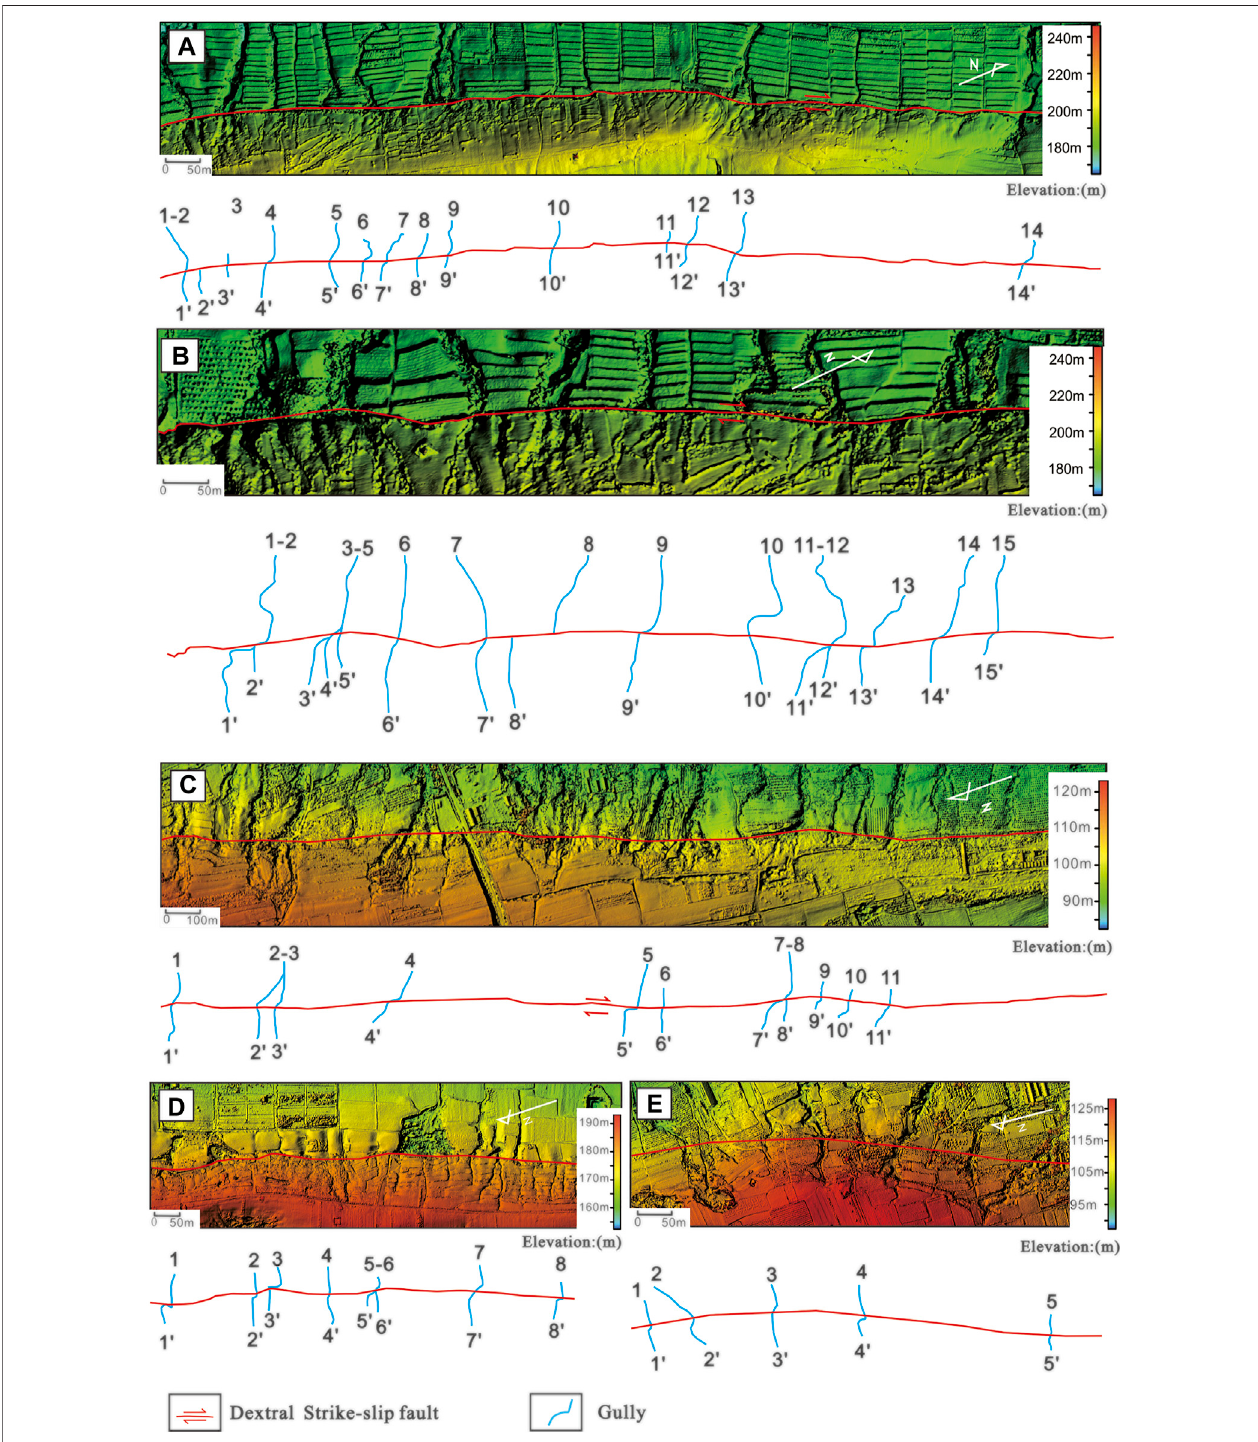
FIGURE3| ThemeasuredtopographyandinterpretationofthegullydislocationsontheNAJF(partial): (A,B) correspondto Figure1C (a2),and (C – E) correspond to Figure 1C (a1).